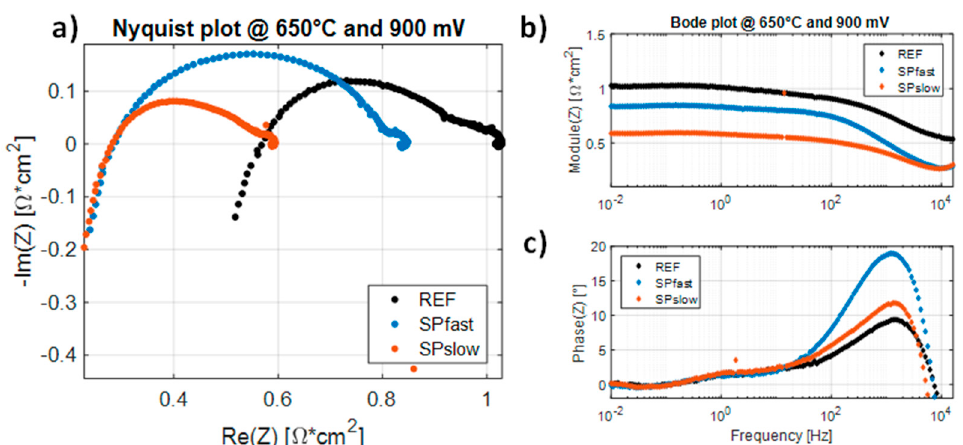
Figure 11. Nyquist ( a ) and Bode ( b , c ) plots of samples REF (black markers), SPfast (blue markers), and SPslow (red markers) measured at 650 °C and 900 mV.